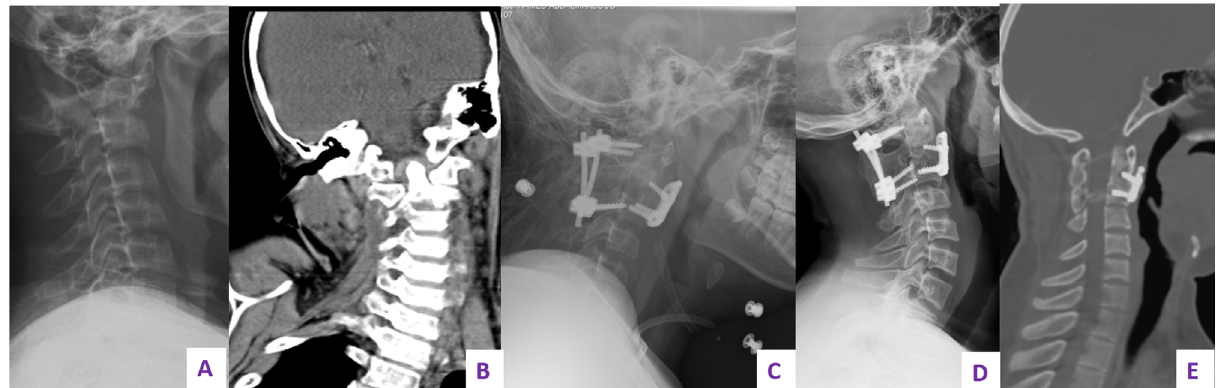
Figure 2. Plain radiograph of cervical spine of a 12-year-old boy diagnosed with LCH showing destruction and atlanto-axial instability, surgery was mandated to avoid neurological affection. (A) Preoperative plain radiograph showing C1 – C2 instability. (B) CT scan showing the instability and lateral tilt of C1 over C2. (C) Postoperative radiograph showing C1 – C2 fi xation. (D) Follow-up radiograph after 1 year. (E) Follow-up CT scan after 5 years showing complete fusion of C1 –